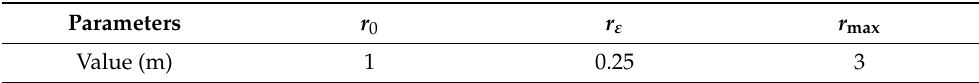
Table 2. Initial parameters for dimension-based selection.